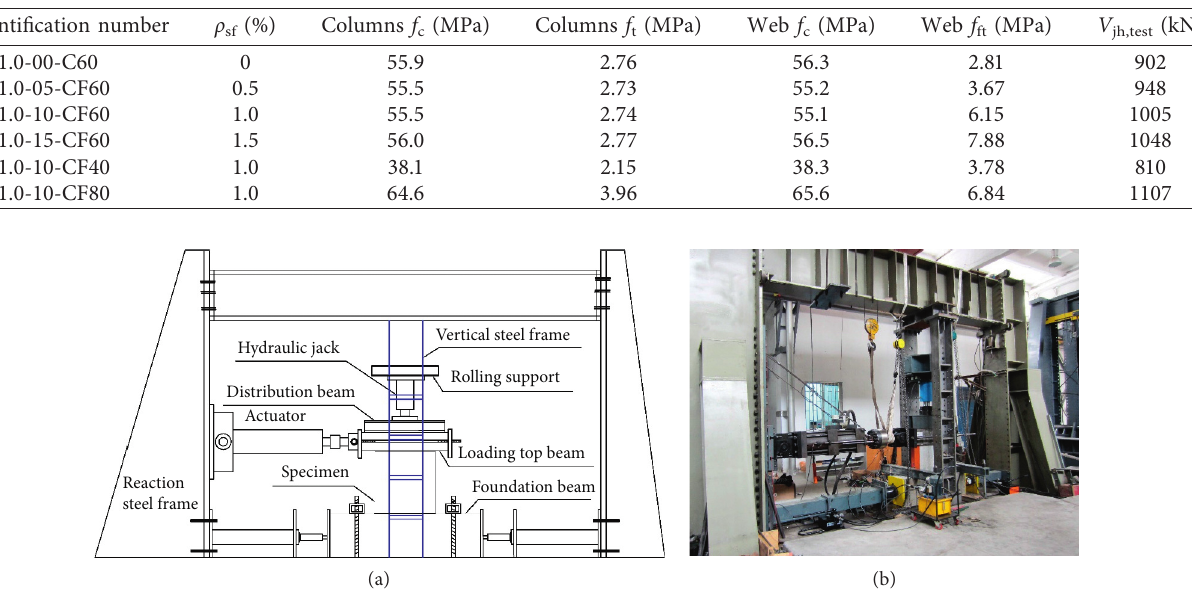
Figure 3: Test set-up. (a) Schematic view. (b) Test